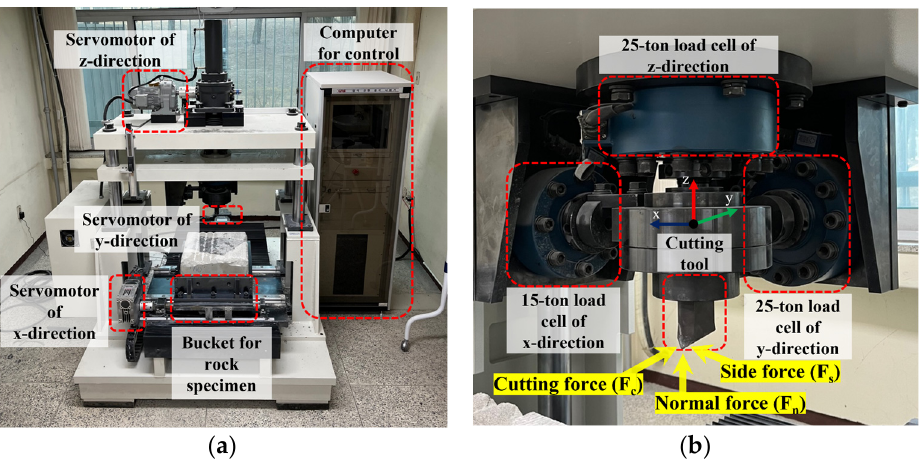
Figure 2. ( a ) Overview of LCM; ( b ) load cells and cutting tool.